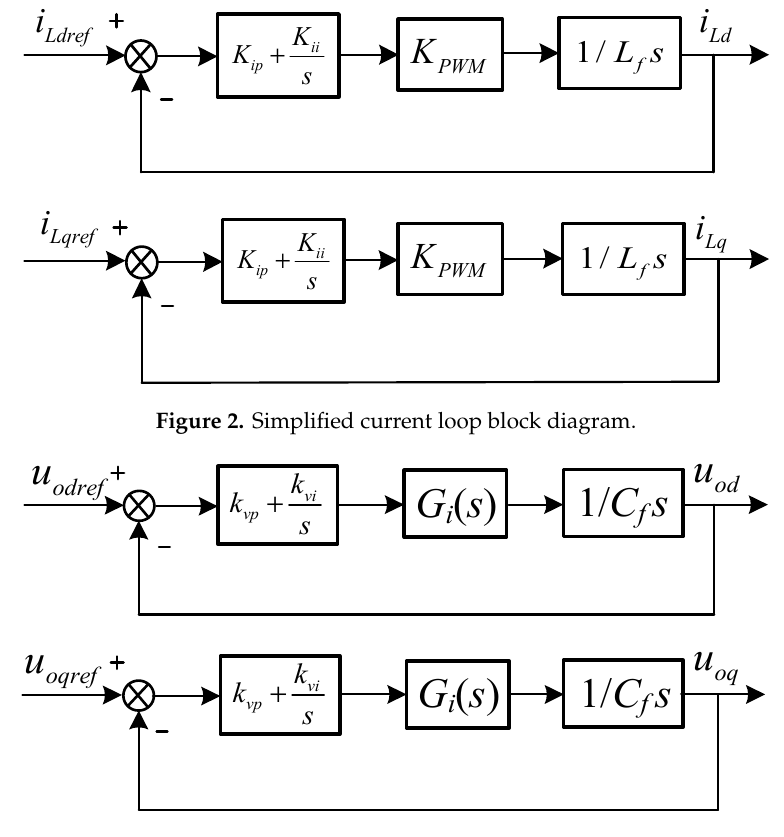
Figure 3. Simplified voltage loop block diagram.